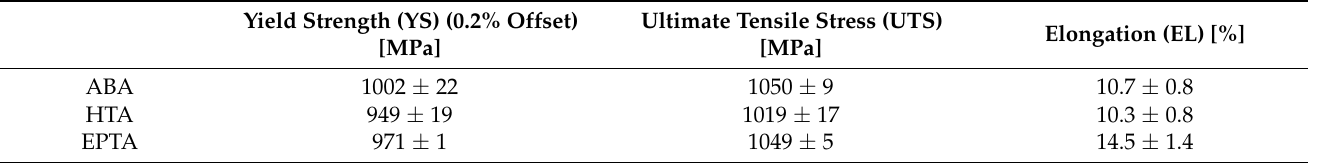
Figure 5. ( a ) Engineering stress–strain curves; ( b ) true stress–strain, work-hardening rate curves, and mechanical properties of the samples; ( c , d ) mechanical-property changes induced by the stabilization annealing; ( e , f ) fracture morphology of HTA; ( g , h ) fracture morphology of EPTA. Table 1. Tensile properties of samples in different